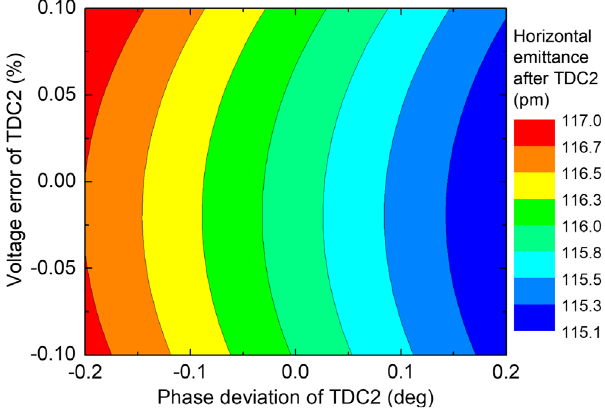
FIG. 10. Horizontal emittance after TDC2 along the relative phase error and voltage error between TDC1 and TDC2.